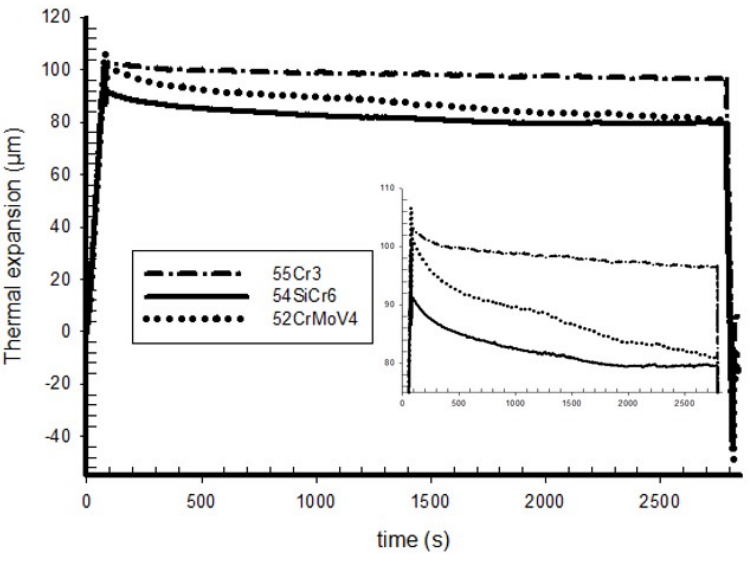
Figure 2. Thermal expansion rates for the three steels.